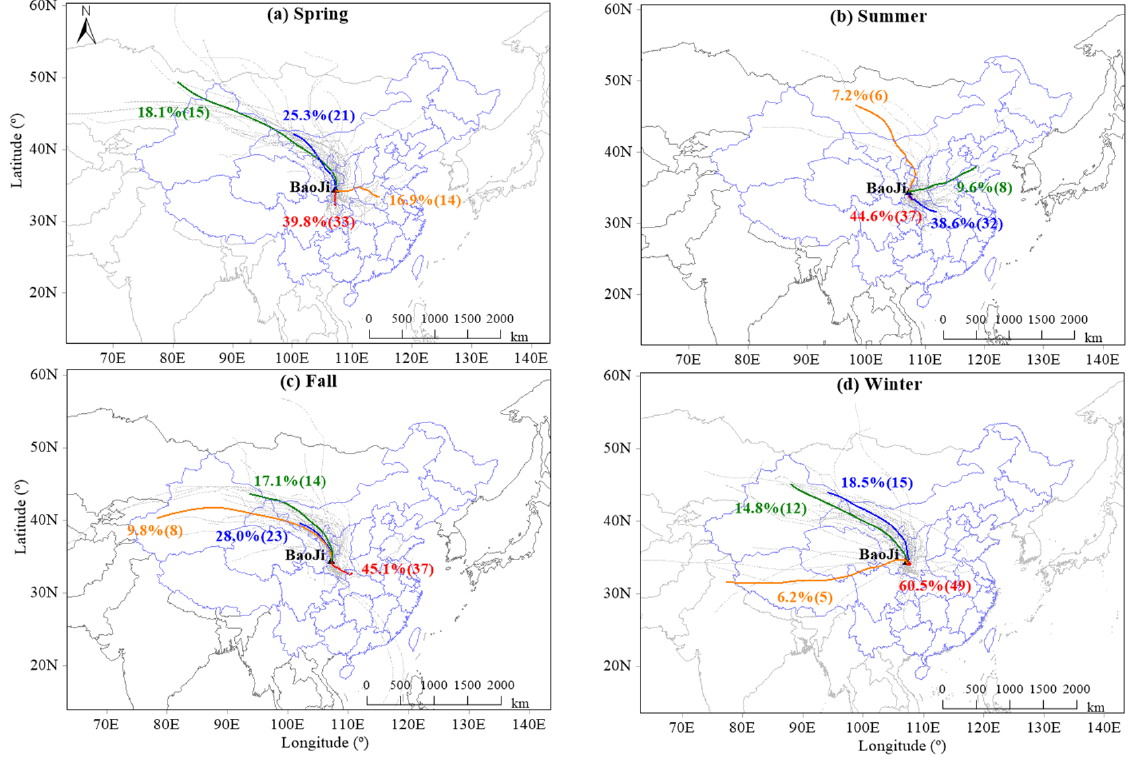
Figure 3. The daily backward trajectories of air masses and the cluster analysis in the four seasons of spring (March–May), summer (June–August), fall (September–November), and winter (Decem-ber–February) of 2018 in Baoji city. The duration of each trajectory was 72 h. The solid colored lines represent air masses with different origins based on the cluster analysis. The values represent the percentage and the number of air mass trajectories with different origins.